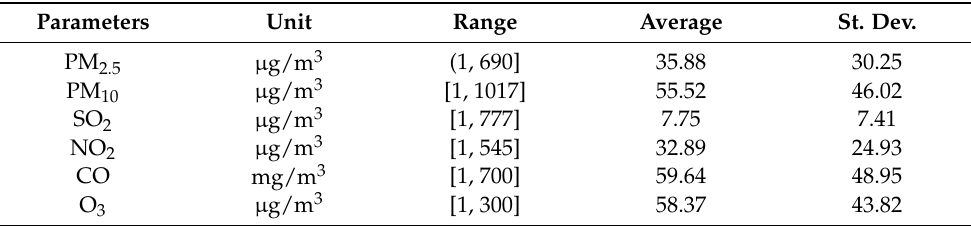
Table 1. Descriptive statistics of pollutant concentration